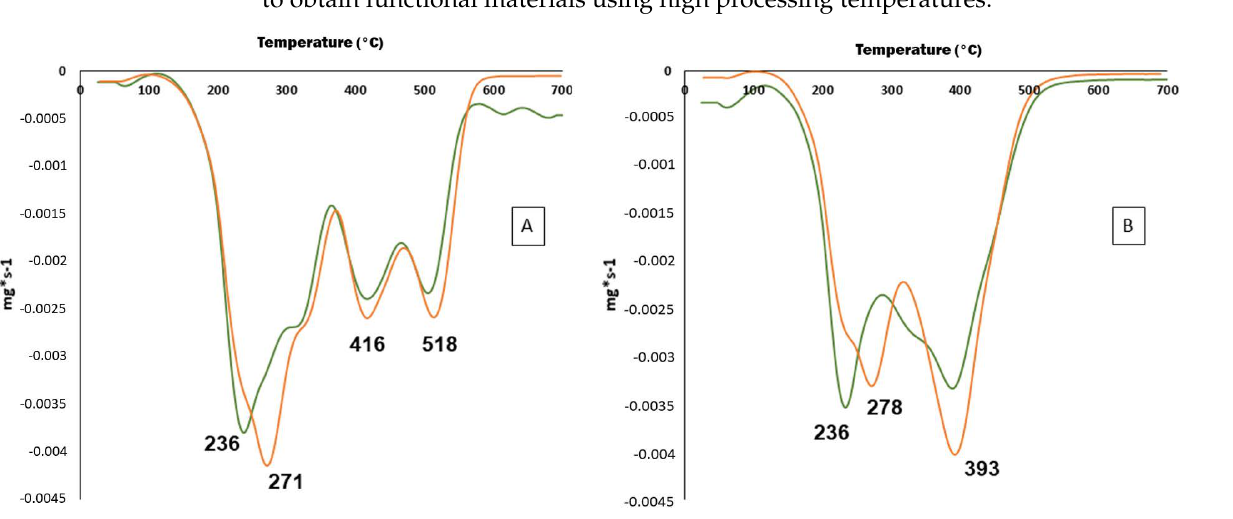
Figure 4. Thermograms of TSE obtained under optimum MAE ( ——– ) and UAE ( —— ) conditions in nitrogen ( A ) and oxygen ( B )